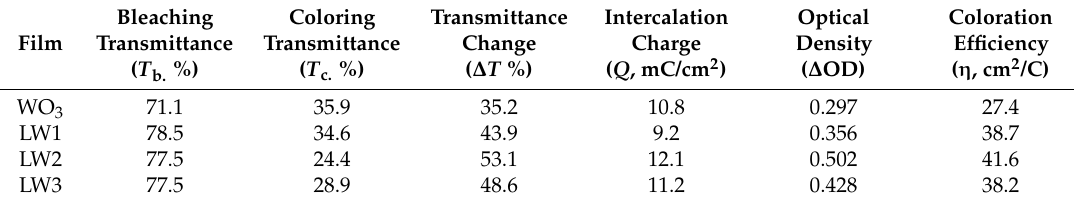
Figure 9. The coloration efficiency of ECDs: ( a ) WO 3 ; ( b ) LW1; ( c ) LW2; ( d ) LW3. Table 3. The properties of ECDs ( λ = 550 nm).